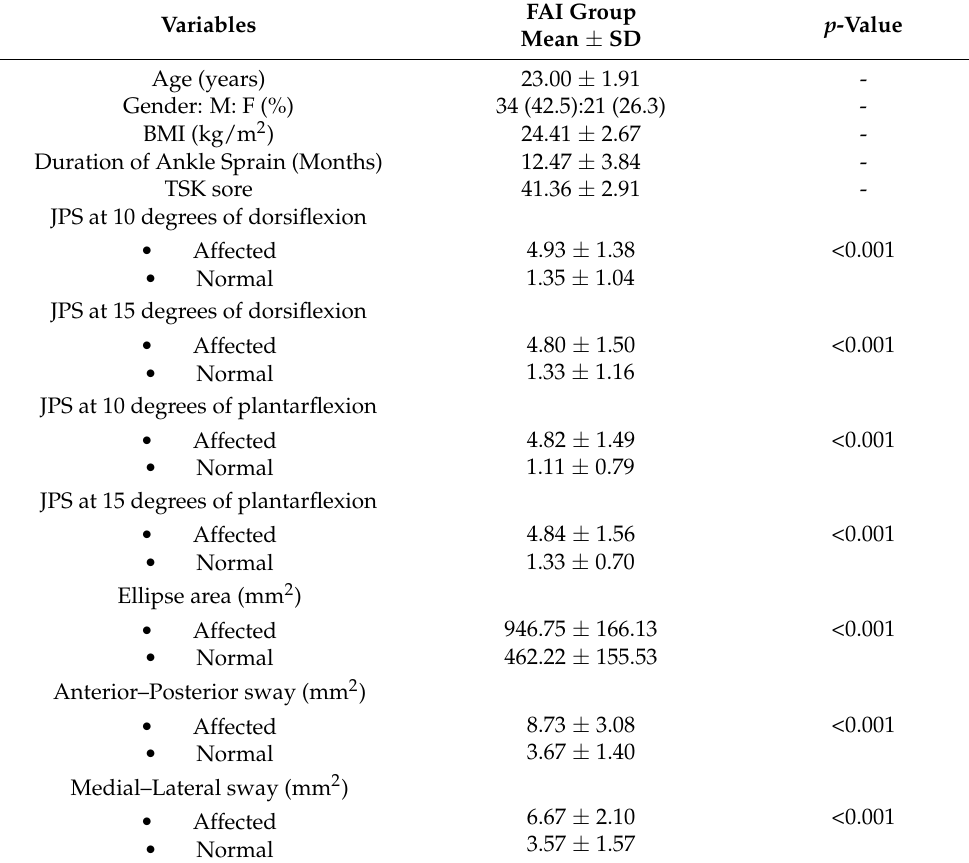
Table 1. Physical and demographic characteristics of participants ( n = 55).